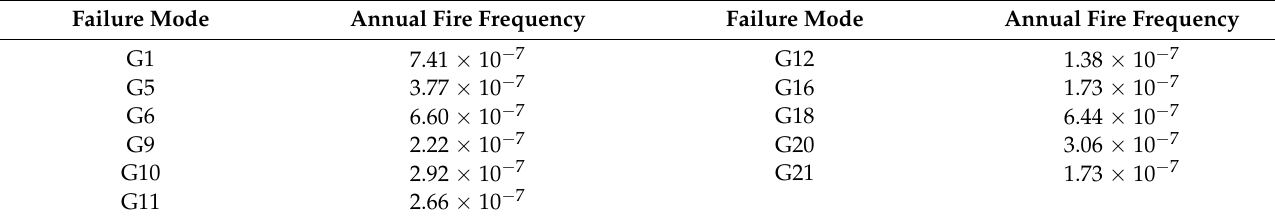
Table 13. The annual fire frequencies of typical failure